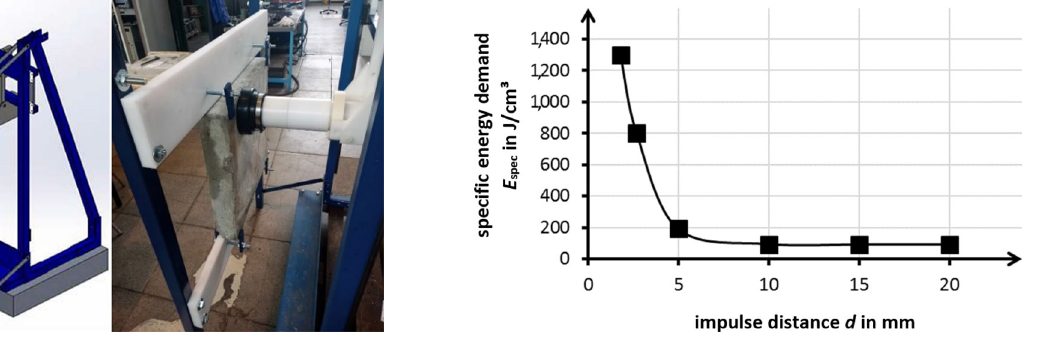
Fig. 9 Scheme and prototype of EIT application for treating vertical and electrode arrangement of the tool